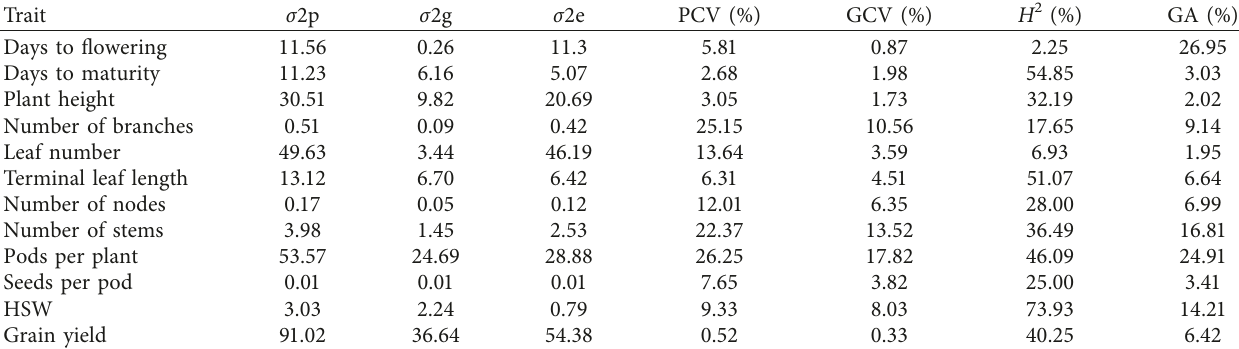
Table 5: Phenotypic and genotypic coefficients of variability, heritability, and genetic advance for genotypes.